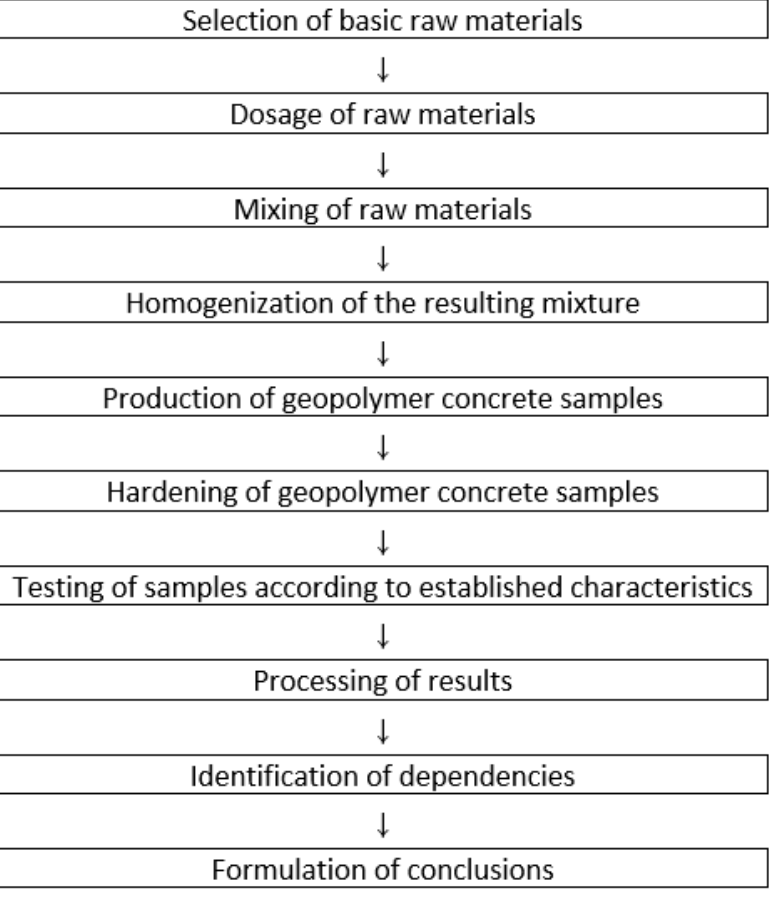
Table 7. Experimental compositions of geopolymer fine-grained concrete.